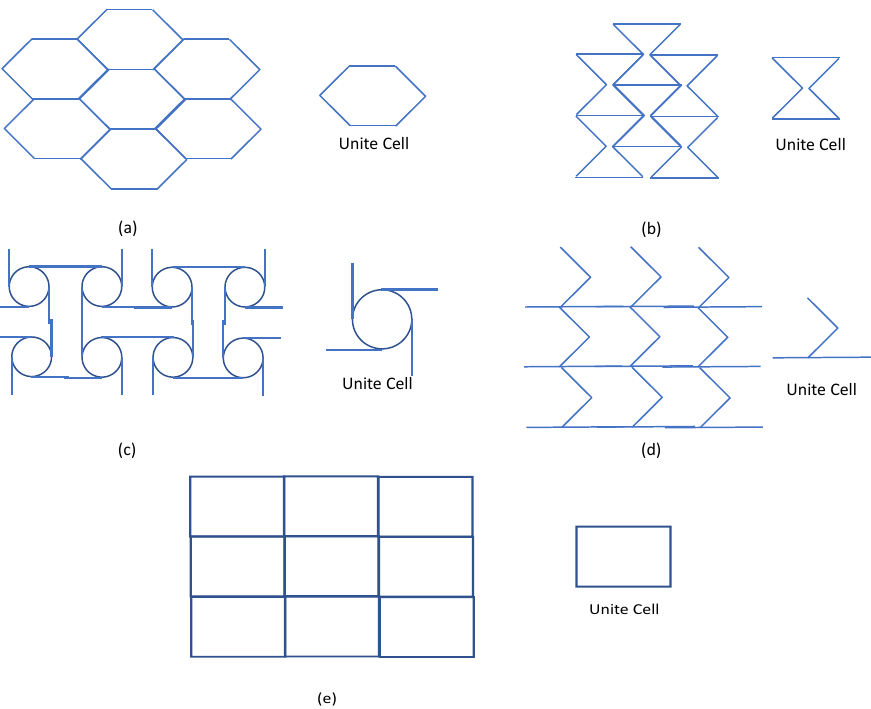
Figure 11. A sample lattice structures, unit cell of ( a ) honeycomb, ( b ) auxetic, ( c ) chiral, ( d ) zero Poisson’s ratio honeycomb, and ( e ) square lattices.